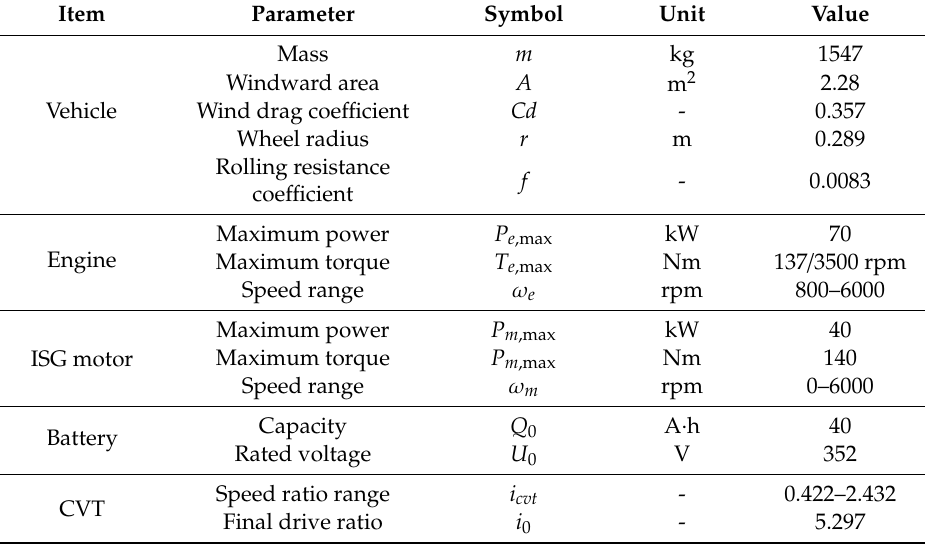
Table 1. Plug-in hybrid electric vehicle (PHEV)